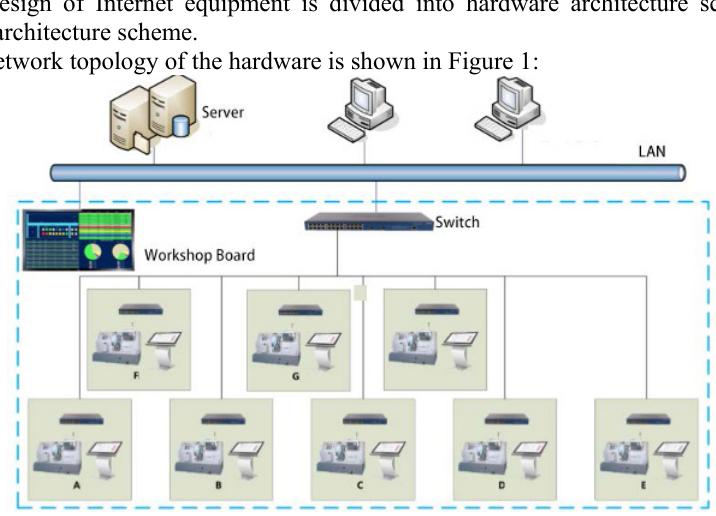
Fig. 1. Network topology of